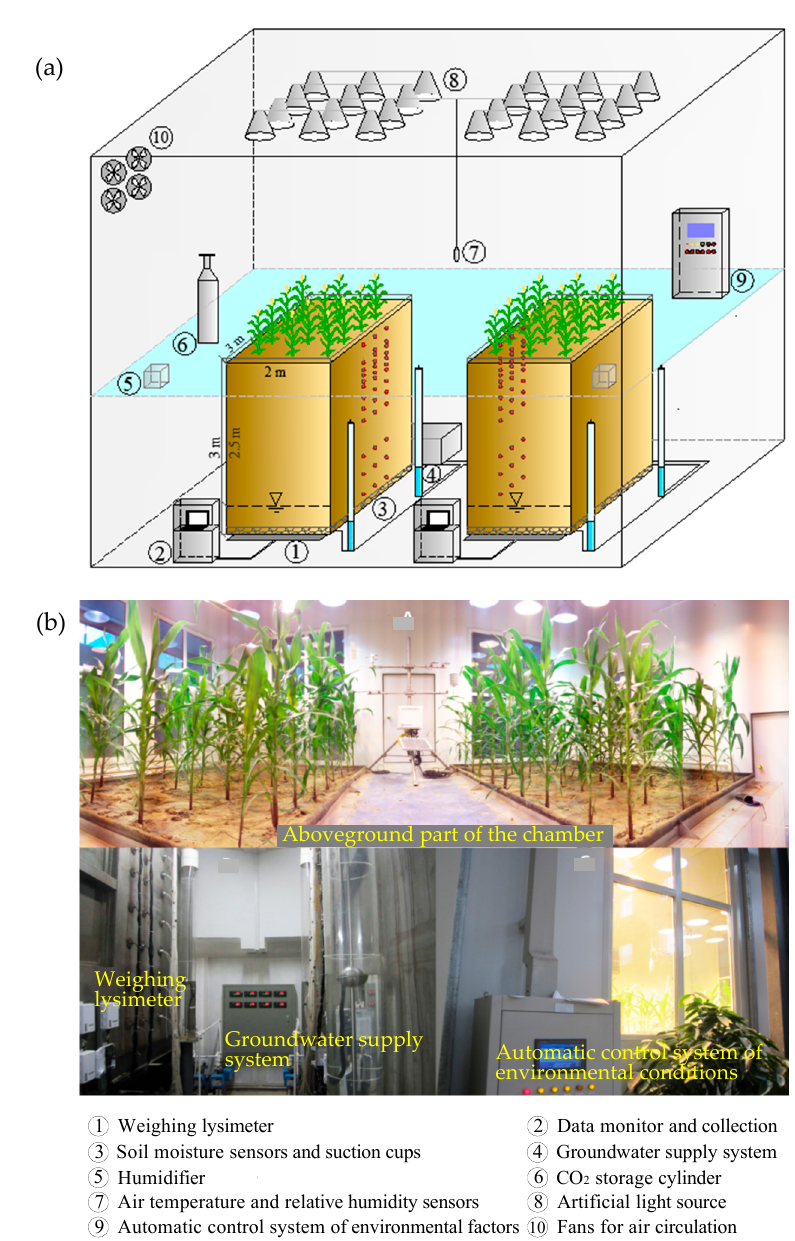
Figure 1. ( a ) Schematic diagram and ( b ) photographs of the coupled device with climate chamber and weighing lysimeters.